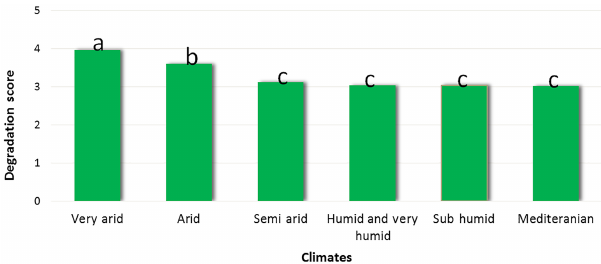
Figure 6. Percent of the area classified under each severity class of degradation for each form of land use.